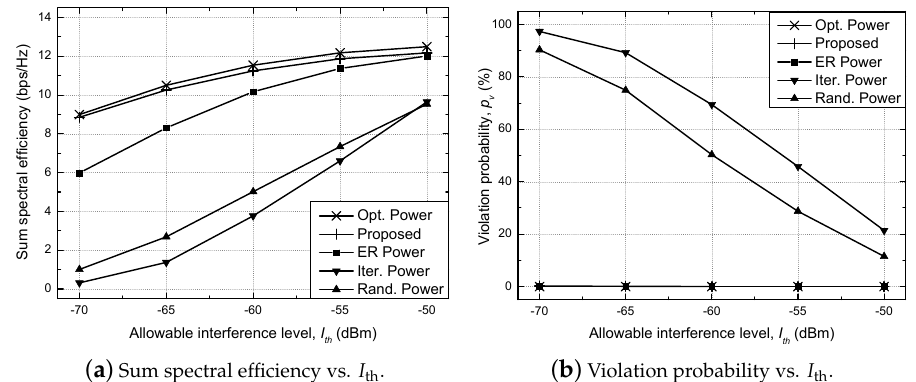
Figure 3. Performance comparison against allowable interference level ( I th ).